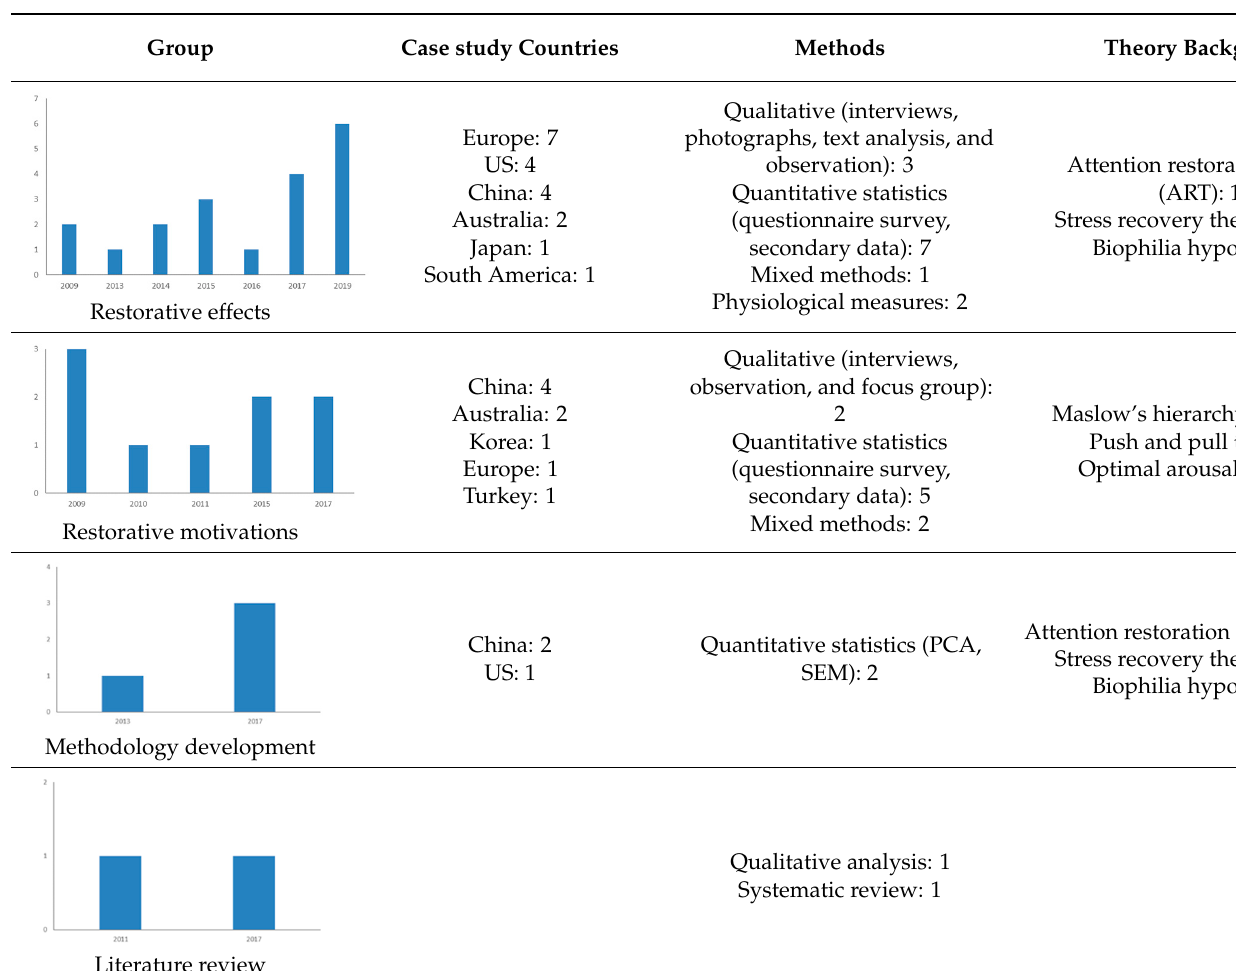
Table 2. Characteristics of tourism studies on restoration from nature.